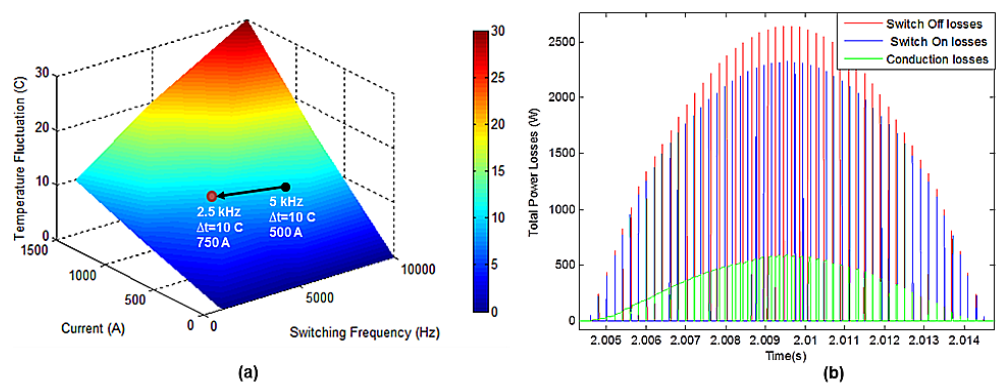
Figure 8. ( a ) Switching frequency effect during 9 m/s wind speed; ( b ) Total power losses at 5 kHz.